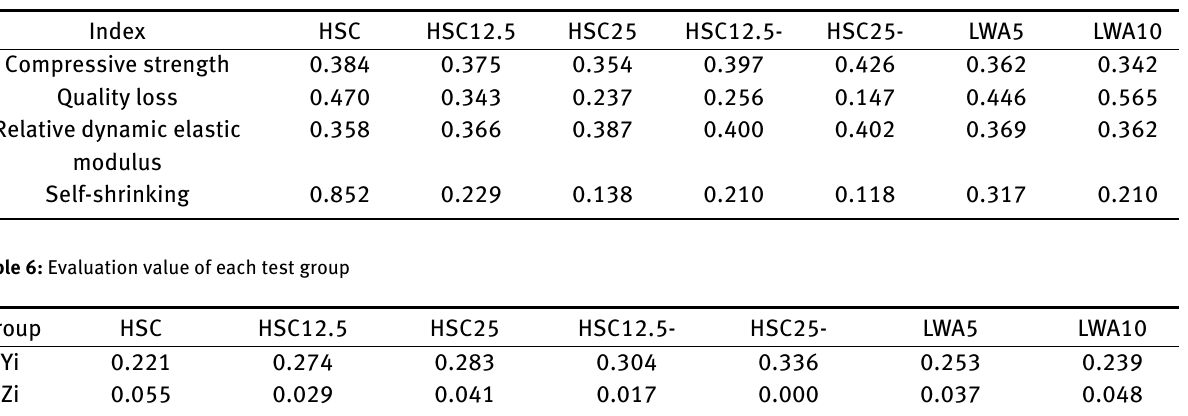
Table 5: Data normalization by vector normalization method